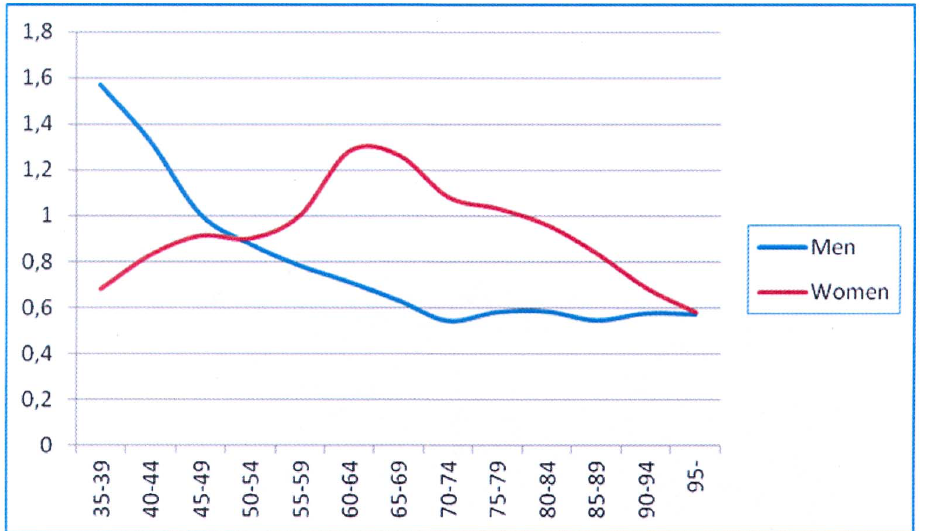
Figure 2. Male and female mortality for cardiovascular diseases in a given 5 year-period expressed as percentage increase from the mortality during preceding 5 years of age.